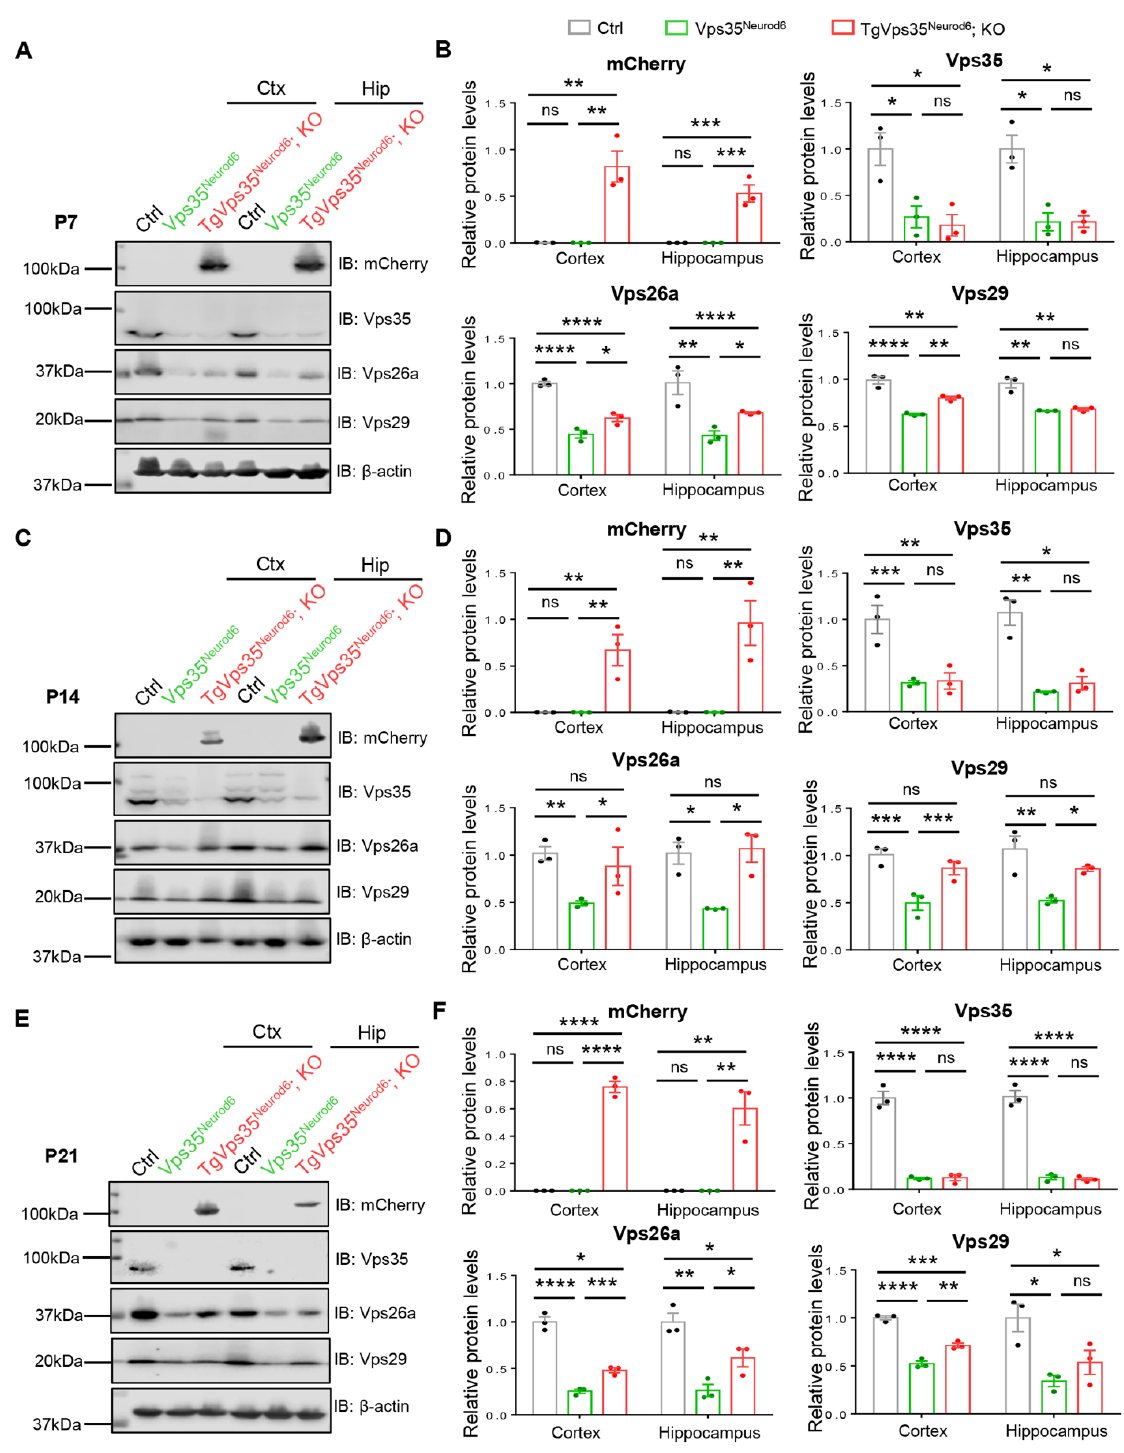
Figure 7. Vps35-mCherry expression modulates retromer complex. ( A , C , E ) Western blot analyses of homogenates of control, Vps35 Neurod6 and TgVps35 Neurod6 ; KO brains at different ages using the indicated antibodies. ( B , D , F ) Quantification analysis of relative protein expression levels from A, C, and E ( n = 3 animals per genotype; one-way ANOVA with Tukey’s multiple- comparison test). Individual data points were shown as dots with group mean ± S.E.M; * p < 0.05; ** p < 0.01; *** p < 0.001; **** p < 0.0001; n.s.: Not